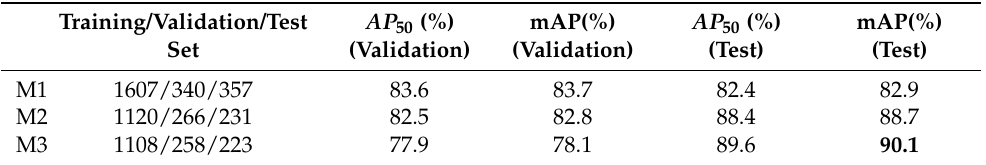
Table 3. AP 50 and mAP scores for Model 1, 2 and 3 on the Klim dataset. Here M1, M2, and M3 refer to Models 1, 2 and 3,